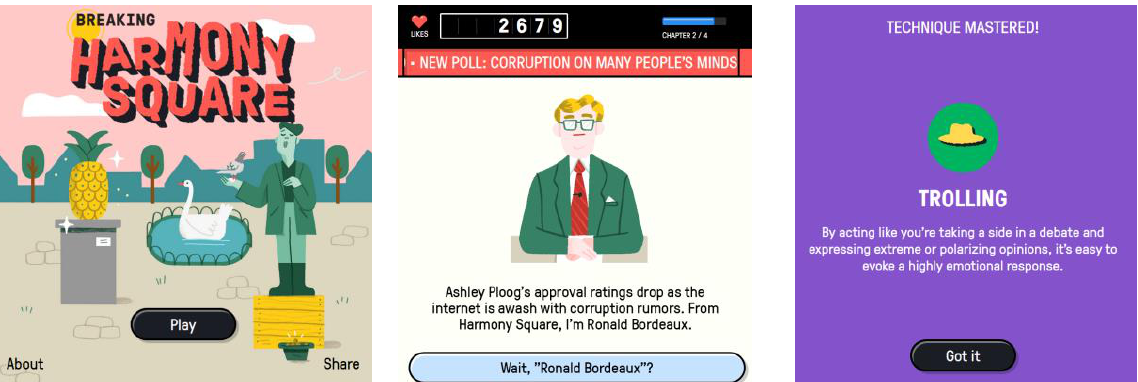
Figure 1. Screenshots of the Harmony Square landing page (left) and game